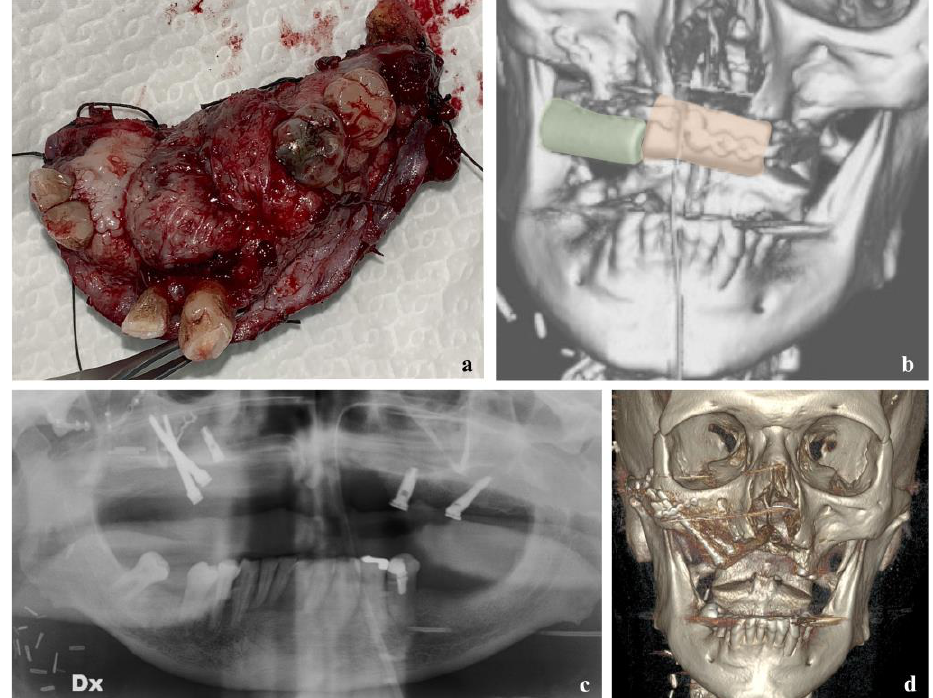
Figure 4. Total flap failure in a patient operated to remove an oral SCC of the maxilla. The patient was affected by epidermolysis bullosa, an autoimmune disease which might have co-played a role in flap failure. ( a ) Right hemi-maxillectomy, including the carcinoma. ( b ) Three-dimensional view of the reconstruction achieved by a two-pieces fibula flap. ( c ) Post-operative OPG showing absence of the necrotic segments. Total flap failure occurred on POD 13. The removal of the necrotic flap was followed by positioning of two right zygomatic implants, three traditional endosseous implants and a temporalis flap. ( d ) Three-dimensional post-operative CT showing the correct positioning of the implants and the osseous defect.